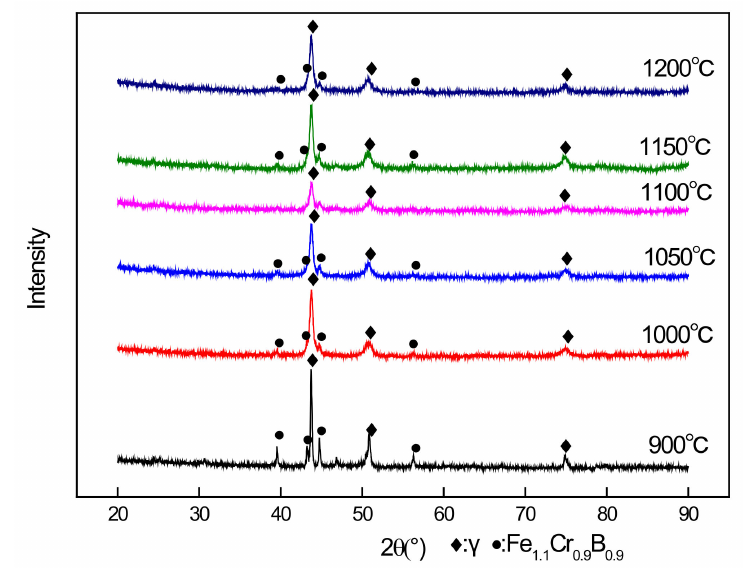
Figure 2. XRD of BSS after different temperatures.